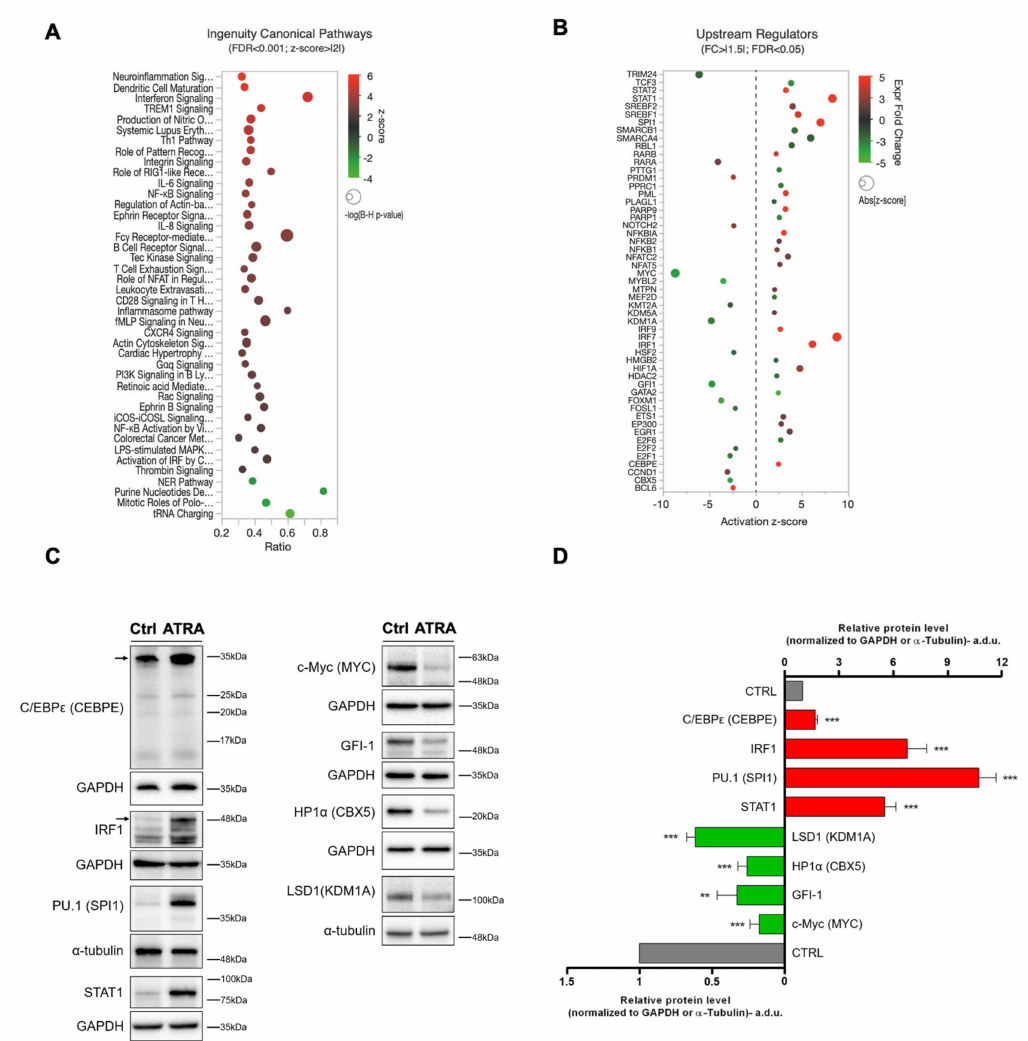
Figure 2. Canonical Pathways and Upstream Regulators from ingenuity pathway analysis (IPA). ( A ) Bubble plot of top canonical pathways as per z-score, which represents a measure of the predicted direction of the pathway activity (z-score ≥ | 2 | was used as cut-o ff ). Each bubble represents a Canonical Pathway and the bubble size is directly proportional to the –log (B-H corrected p -value), i.e., the higher the bubble size, the more significant is the result; bubble color represents z-scores as per the legend. In X -axis, ratios of overlap among ATRA-regulated genes (FC > | 1.5 | ; False Discovery Rate (FDR) < 5%) and the total genes composing the indicated pathways. ( B ) Bubble plot of predicted activated (z-score ≥ 2) or inhibited (z-score ≤ − 2) upstream transcriptional regulators (TR) that are significantly regulated by ATRA (FC > | 1.5 | ; FDR < 5%). Upstream TR are sorted in alphabetical order. Each bubble represents a TR where the bubble size is proportional to the z-score (absolute value) and colors represent up-regulated TR (red; FC ≥ 1.5) or down-regulated TR (green; FC ≤ − 1.5) in ATRA- vs. vehicle-treated NB4 cells. In X -axis, z-scores are shown. ( C ) Validation of some di ff erentially expressed Upstream TR in NB4 cells treated with 1 µ M ATRA for 120 h (ATRA) in comparison with control (Ctrl). Representative immunoblot analysis of C / EBP ε , c-Myc, GFI-1, HP1 α , IRF1, LSD1, PU.1, and STAT1. GAPDH and α -Tubulin were used as loading controls. Experiments were repeated at least three times. ( D ) Quantification of immunoblot experiments. Data are reported as mean ± SD of experiments repeated at least three times (Student’s t-test, ** p < 0.01; *** p < 0.001, with respect to relative controls; a.d.u., arbitrary densitometric